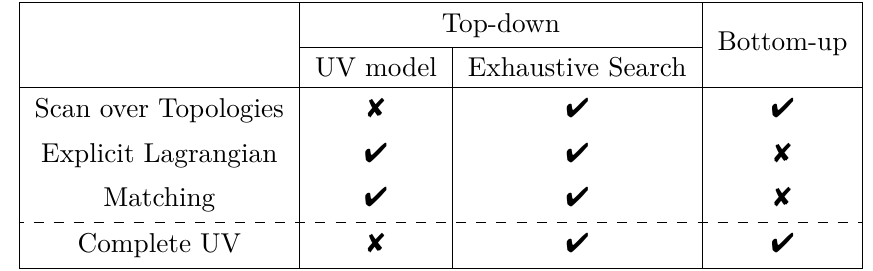
Comparison among the different approaches to obtain the UV resonance/operator